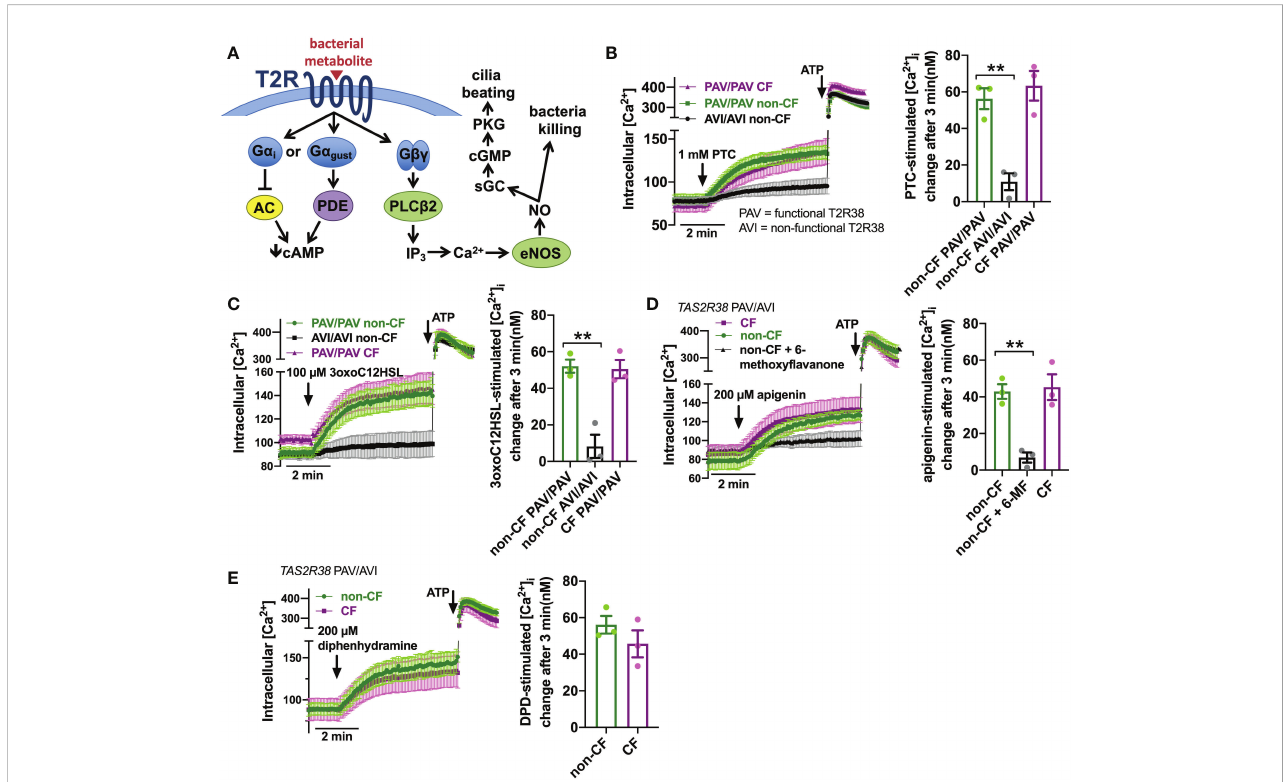
FIGURE 2 Ca 2+ responses to T2R agonists were not different in CF vs. Non-CF cells. (A) While the G a arm of the T2R pathway typically lowers cAMP via G a gustducin increase in phosphodiesterase (PDE) activity or G a i lowering of adenylyl cyclase (AC) (26), T2R activation results in elevation of Ca 2+ downstream of G bg -stimulated phospholipase C (PLC) to generate inositol trisphosphate (IP 3 ), activating the IP 3 receptor to release intracellular Ca 2+ to activate endothelial nitric oxide synthase (eNOS) to produce nitric oxide (NO). The NO can both directly kill bacteria as well as activate soluble guanylyl cyclase (sGC) to increase cyclic GMP (cGMP) to activate protein kinase G (PKG), which phosphorylates ciliary proteins to increase ciliary beating. (B) Left, traces of Ca 2+ indicator dye Fluo-4 in primary nasal air-liquid interface cultures (ALIs) genotyped as TAS2R38 PAV/PAV (homozygous functional) CF or non-CF as well as non-CF TAS2R38 AVI/AVI (homozygous non-functional) during stimulation with T2R38 agonist phenylthiocarbamide (PTC). Right, bar graph showing peak PTC-stimulated Ca 2+ response. No signi fi cant difference between non-CF and CF PAV/PAV, but non-CF AVI/AVI was signi fi cantly lower than non-CF PAV/PAV by one-way ANOVA with Bonferroni posttest; ** p <0.01. (C) Traces and bar graph similar to B but with cells stimulated with T2R38 agonist 3oxoC12HSL. No signi fi cant difference between non-CF and CF PAV/PAV, but non-CF AVI/AVI was signi fi cantly lower than non-CF PAV/ PAV by one-way ANOVA with Bonferroni posttest; ** p <0.01. (D) Traces (left) and bar graph (right) showing Fluo-4 Ca 2+ responses in CF and non-CF ALIs genotyped as AVI/PAV TAS2R38 during stimulation with T2R14 agonist apigenin. While there was no difference between CF and non-CF ALIs